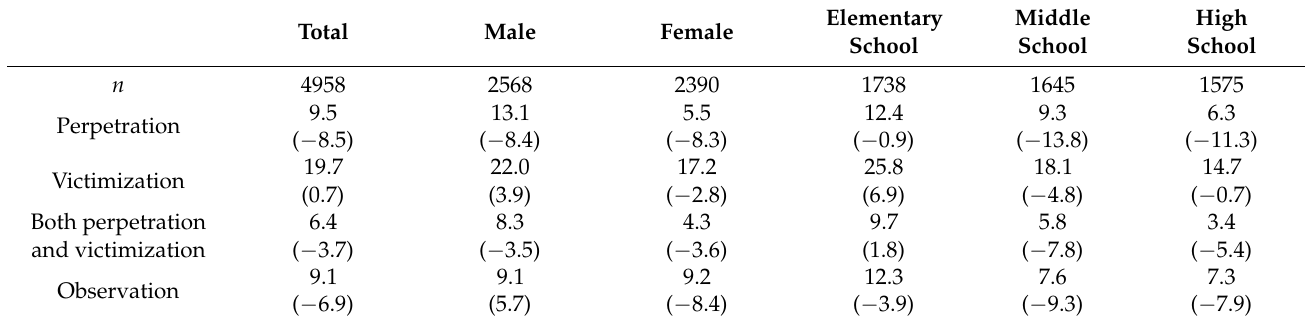
Table 4. Change in cyberbullying experience rate in 2020 compared to